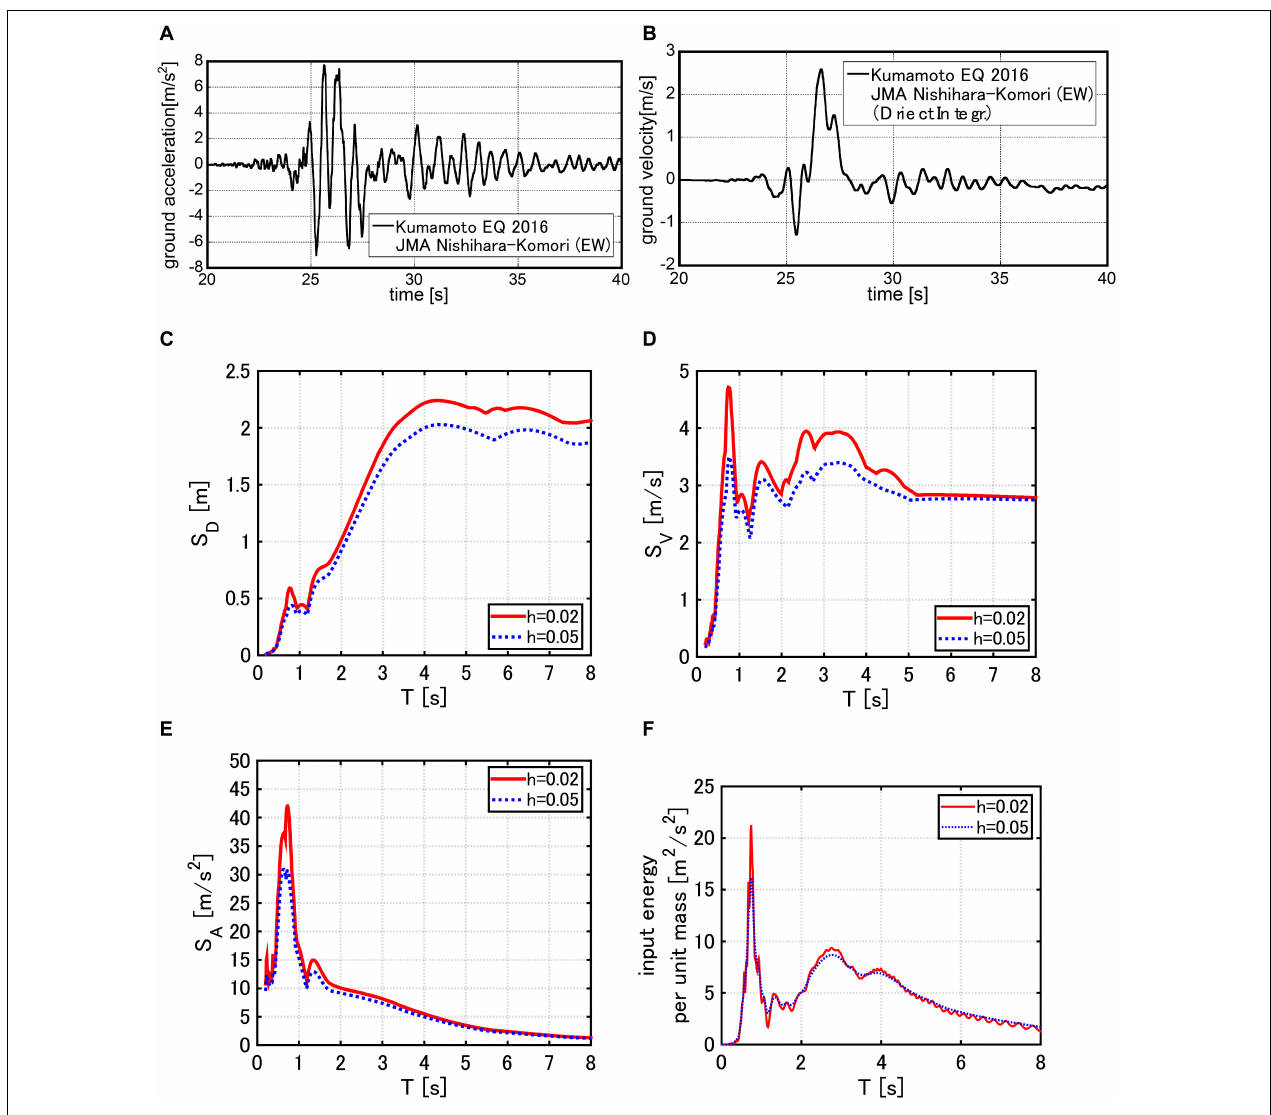
FIGURE 12 | Long-period pulse-type ground motion of extremely large amplitude, (A) Ground acceleration of JMA Nishiharamura-Komori (EW) wave, (B) Ground velocity of JMA Nishiharamura-Komori (EW) wave, (C) Displacement response spectrum, (D) Velocity response spectrum, (E) Acceleration response spectrum (Hashizume and Takewaki, 2020), and (F) Input energy